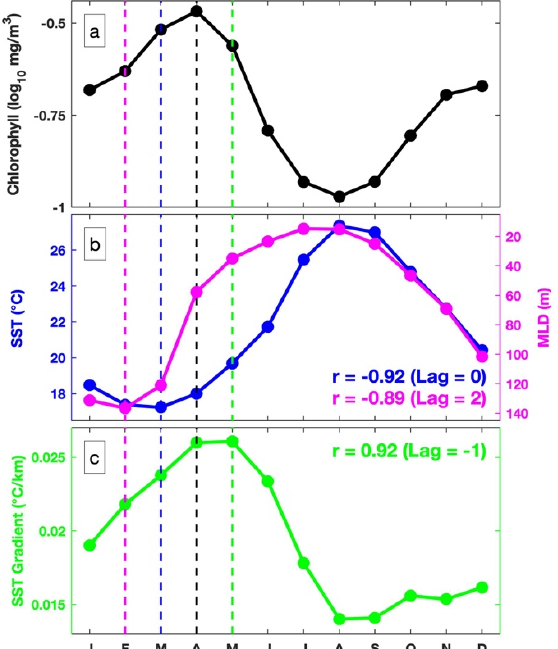
Figure 7. Monthly averaged ( a ) Chl-a (log 10 (mg/m 3 )), ( b ) SST (blue, °C) and MLD (magenta, m), and ( c ) SST gradient (°C/km). The vertical dashed lines represent the annual peaks for Chl-a (black) and SST gradient (green) and annual troughs for SST (blue) and MLD (magenta). The correlation between Chl-a and other factors and the associated lag to obtain the largest correlation are labeled in the corresponding panels, where a positive (negative) value indicates that the parameter is leading (lagging) the variability in Chl-a.